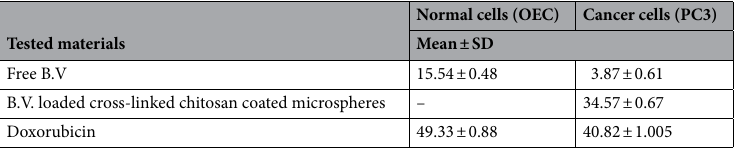
Table 4. IC 50 value of tested materials (Free B.V., B.V. loaded cross-linked chitosan coated microspheres and doxorubicin) on PC3 and OEC.